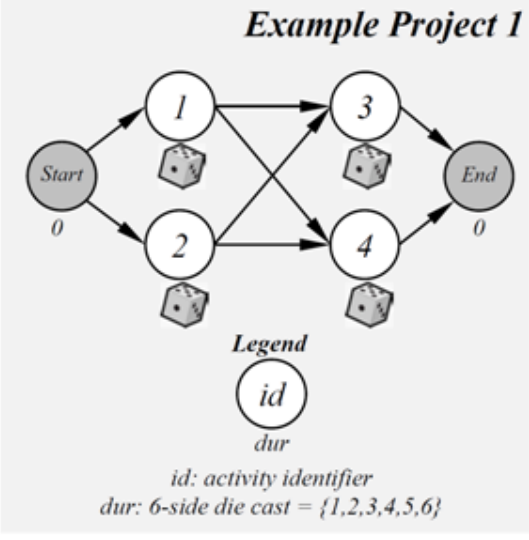
Figure 5. AoN network of the example project 1 assuming variable activity